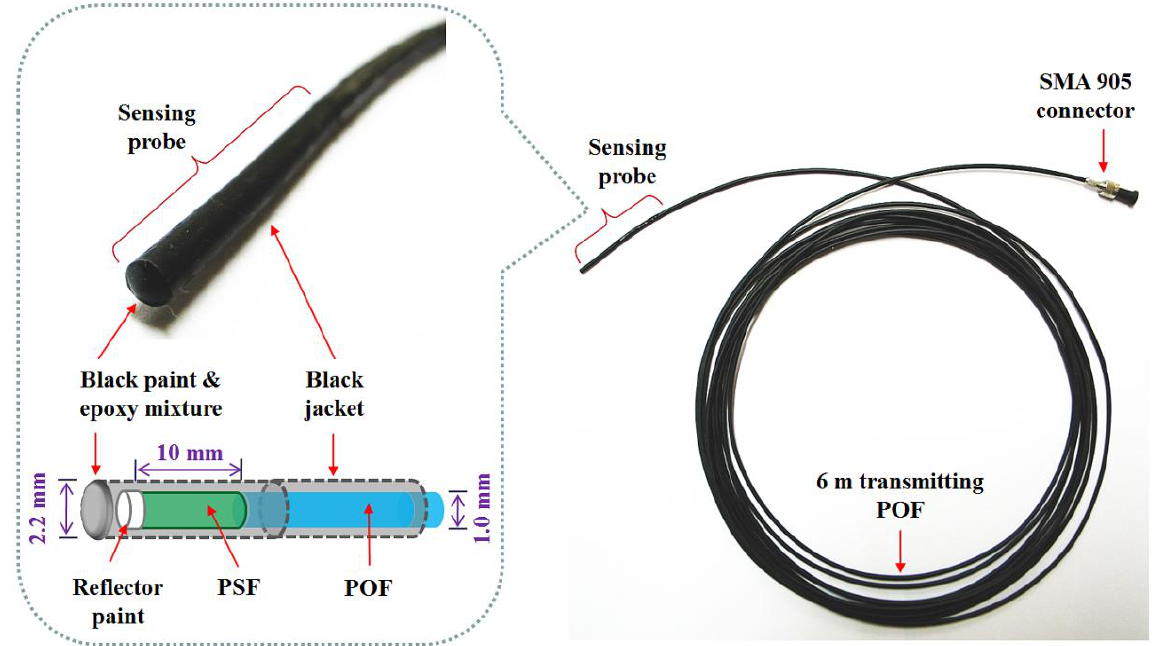
Figure 1. Completed sensing probe and its internal structure to produce scintillating